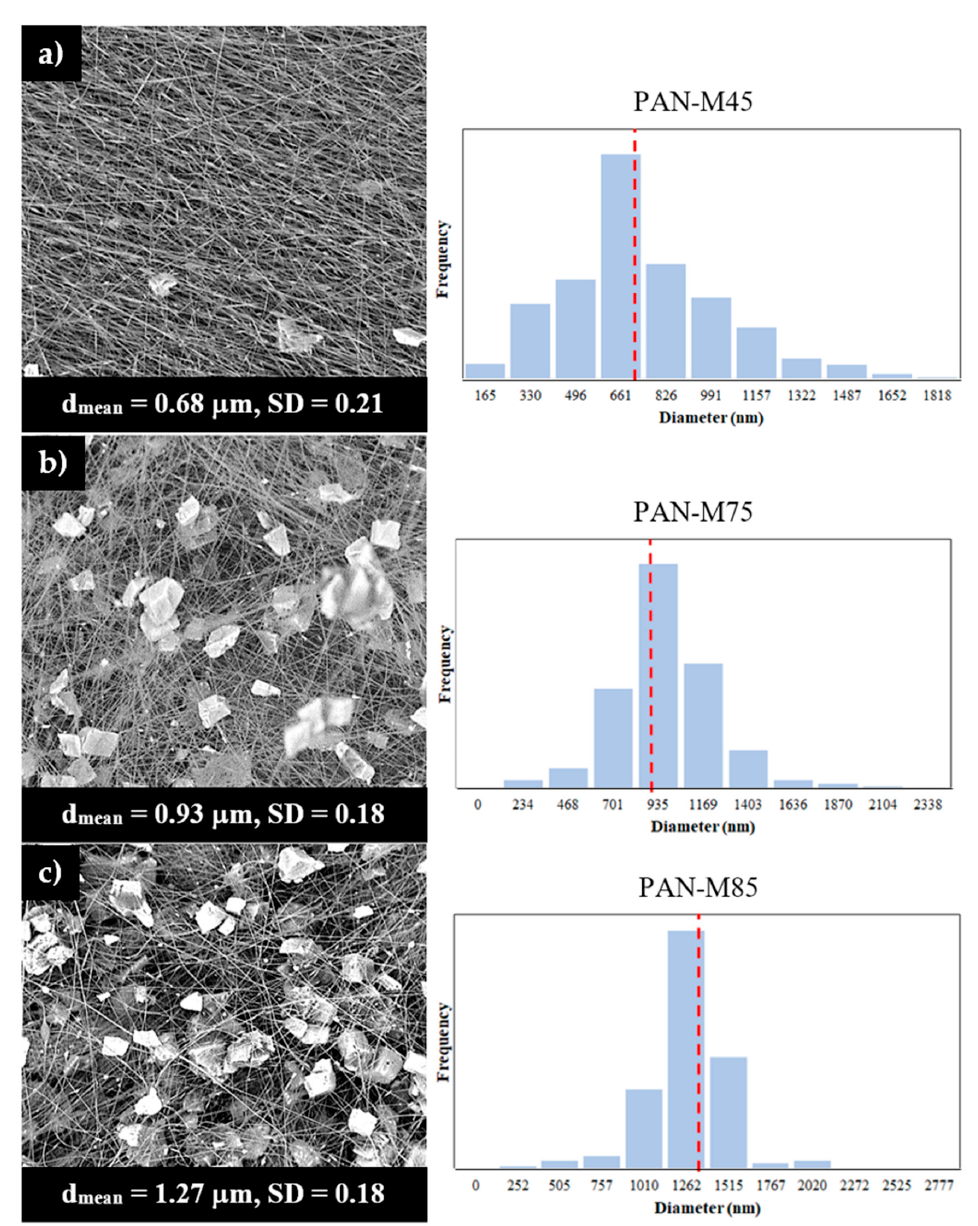
Figure 4. SEM images and related mean diameters evaluation of PAN / SAPO-34M samples at increasing zeolite concentrations (45, 75 and 85 wt%) . 223